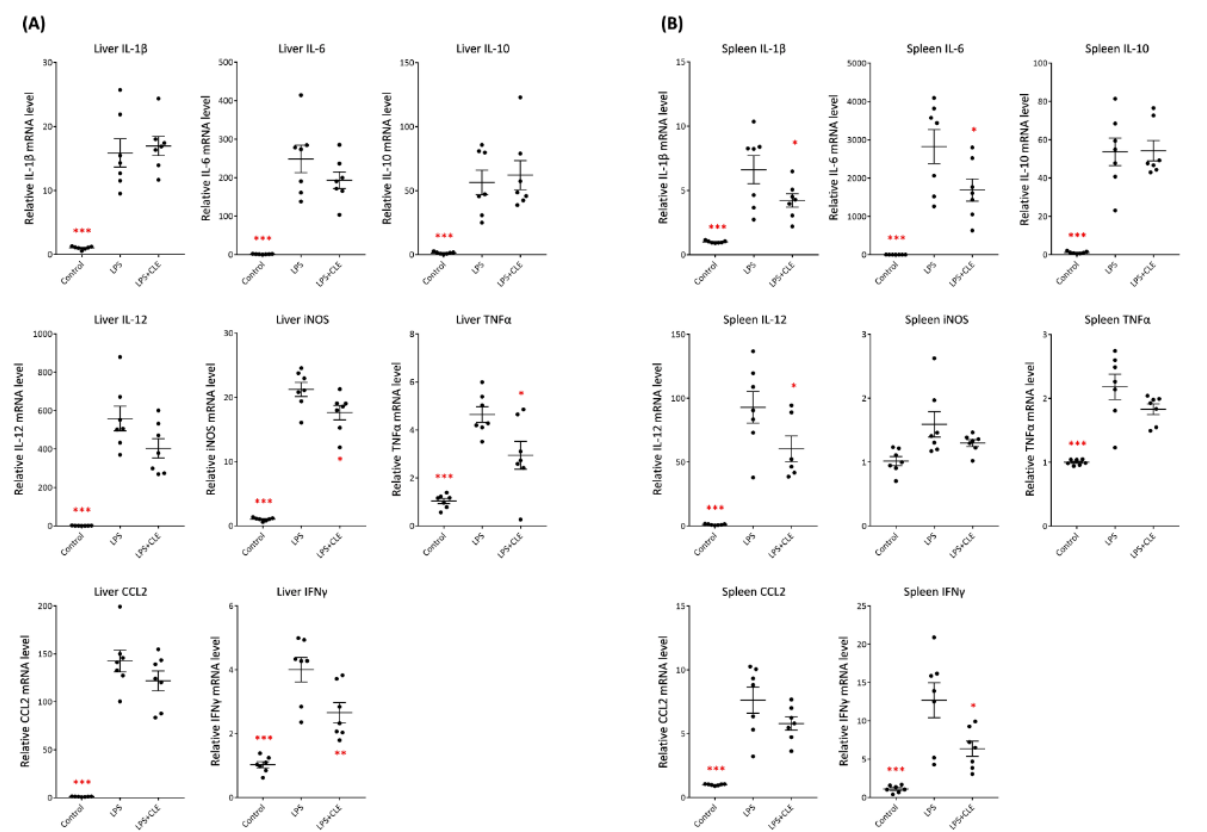
Figure 8. Effect of an aqueous extract from leaves of Citrus unshiu (CLE) on gene expression of inflammation-associated proteins in LPS-induced systemic inflammation mice. Control and LPS groups received water for 7 consecutive days, while LPS + CLE group received CLE (300 mg/kg). LPS and LPS + CLE groups were intraperitoneally injected with LPS (5 mg/kg) 2 h after the last oral administration on day 7, whereas control group was injected with 200 µL of PBS. Two hours later, all mice were anesthetized, and the liver and spleen were collected for real-time RT-PCR. Data are represented as mean ± SEM ( n = 7). * p < 0.05, ** p < 0.01, or *** p < 0.001 against control by Dunnett’s test. Liver ( A ), spleen ( B ).